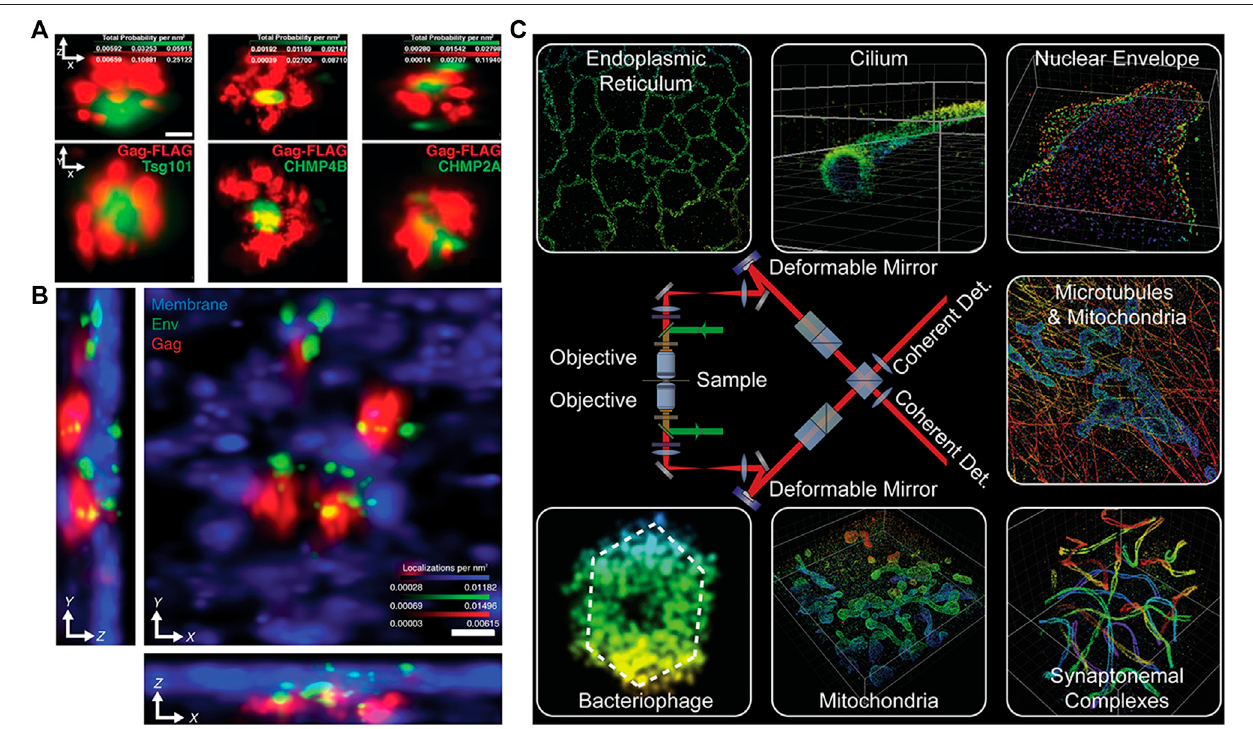
FIGURE8| Applications of4Pi-SMLMin3Dimaging. (A) Two-coloriPALMimagingofGag-FLAG(red) andPSCFP2-ESCRTprobes(includingTsg101,CHMP4B, and CHMP2A) (green). Axial (top) and lateral (bottom) viewsshow localization ofPSCFP2-ESCRT probes with theHIV Gaglattice. The fi gure ismodi fi ed with permission fromRef.45.Copyright©2018SpringerNature. (B) Three-coloriPALMimagingofsubviralangulardistributionsofEnvatHIV-1assemblysites.Lateral(center)andaxial (lower and left) views show individual Env clusters (green) with four assembly sites (red) protruding from the plasma membrane (blue). The fi gure is modi fi ed with permission from Ref. 46. Copyright © 2014 American Association for the Advancement of Science. (C) A sketch of 4Pi-SMSN and some imaging results. The fi gure is modi fi ed with permission from Ref. 49. Copyright © 2016 Elsevier. Scale bars: 50 nm (A) and 100 nm (B) .